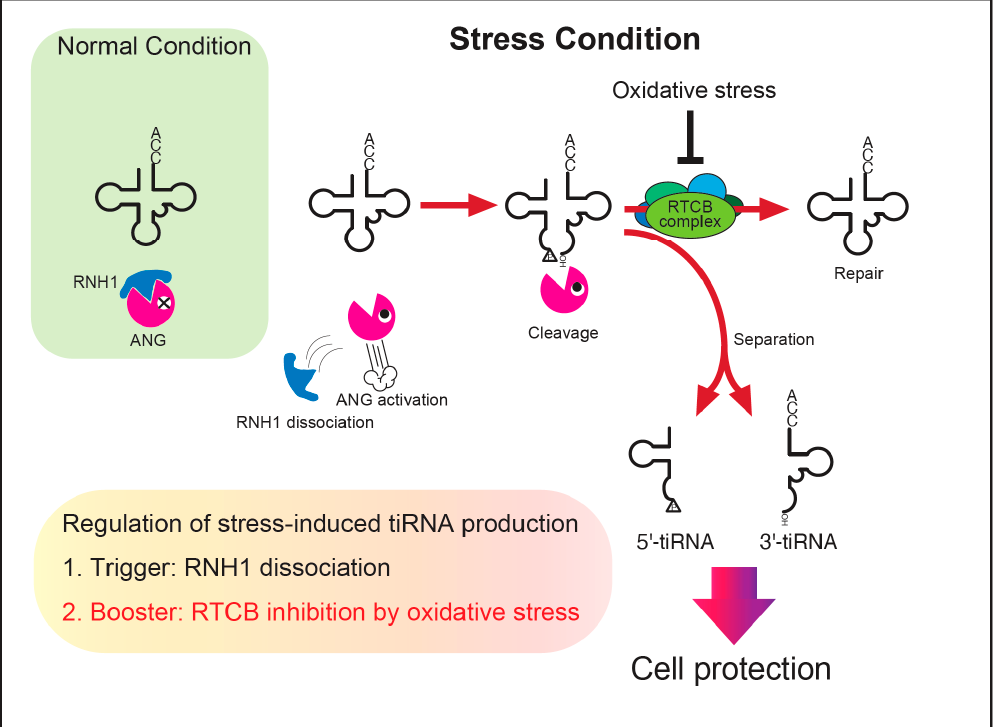
Figure 6. A proposed model of the regulation of stress-induced tiRNA production. Under normal conditions, ANG (and other RNase A superfamily enzymes) is inhibited by RNH1. Once cells are exposed to stress, the RNases become activated through RNH1 dissociation, cleaving tRNAs into tiRNAs. A part of tiRNAs is repaired to intact tRNAs before separation. Under the condition where oxidative stress coexists, the repair of tRNAs is repressed due to inhibition of the RTCB ligase complex, resulting in increased levels of separated tiRNAs that contribute to cell protection against adverse conditions. We propose that the net amount of tiRNA production is estimated by two factors, a trigger (RNH1 dissociation) and a booster (RTCB inhibition).